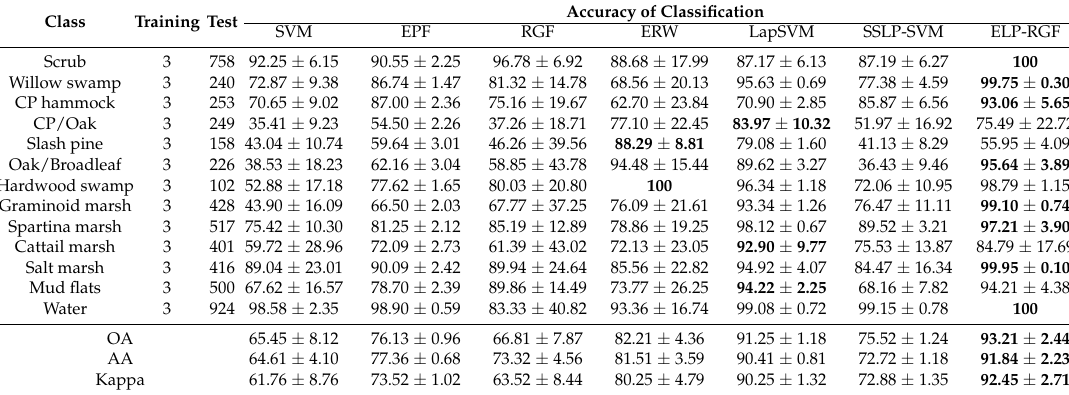
Figure 10. Classification maps of different methods for the University of Pavia image ( a ) Reference image; ( b ) SVM method; ( c ) EPF method; ( d ) RGF method; ( e ) ERW method; ( f ) LapSVM method; ( g ) SSLP-SVM method and ( h ) ELP-RGF method. Table 3. Individual class accuracies, OA, AA and Kappa coefficient (in percentage) for the Kennedy Space Center